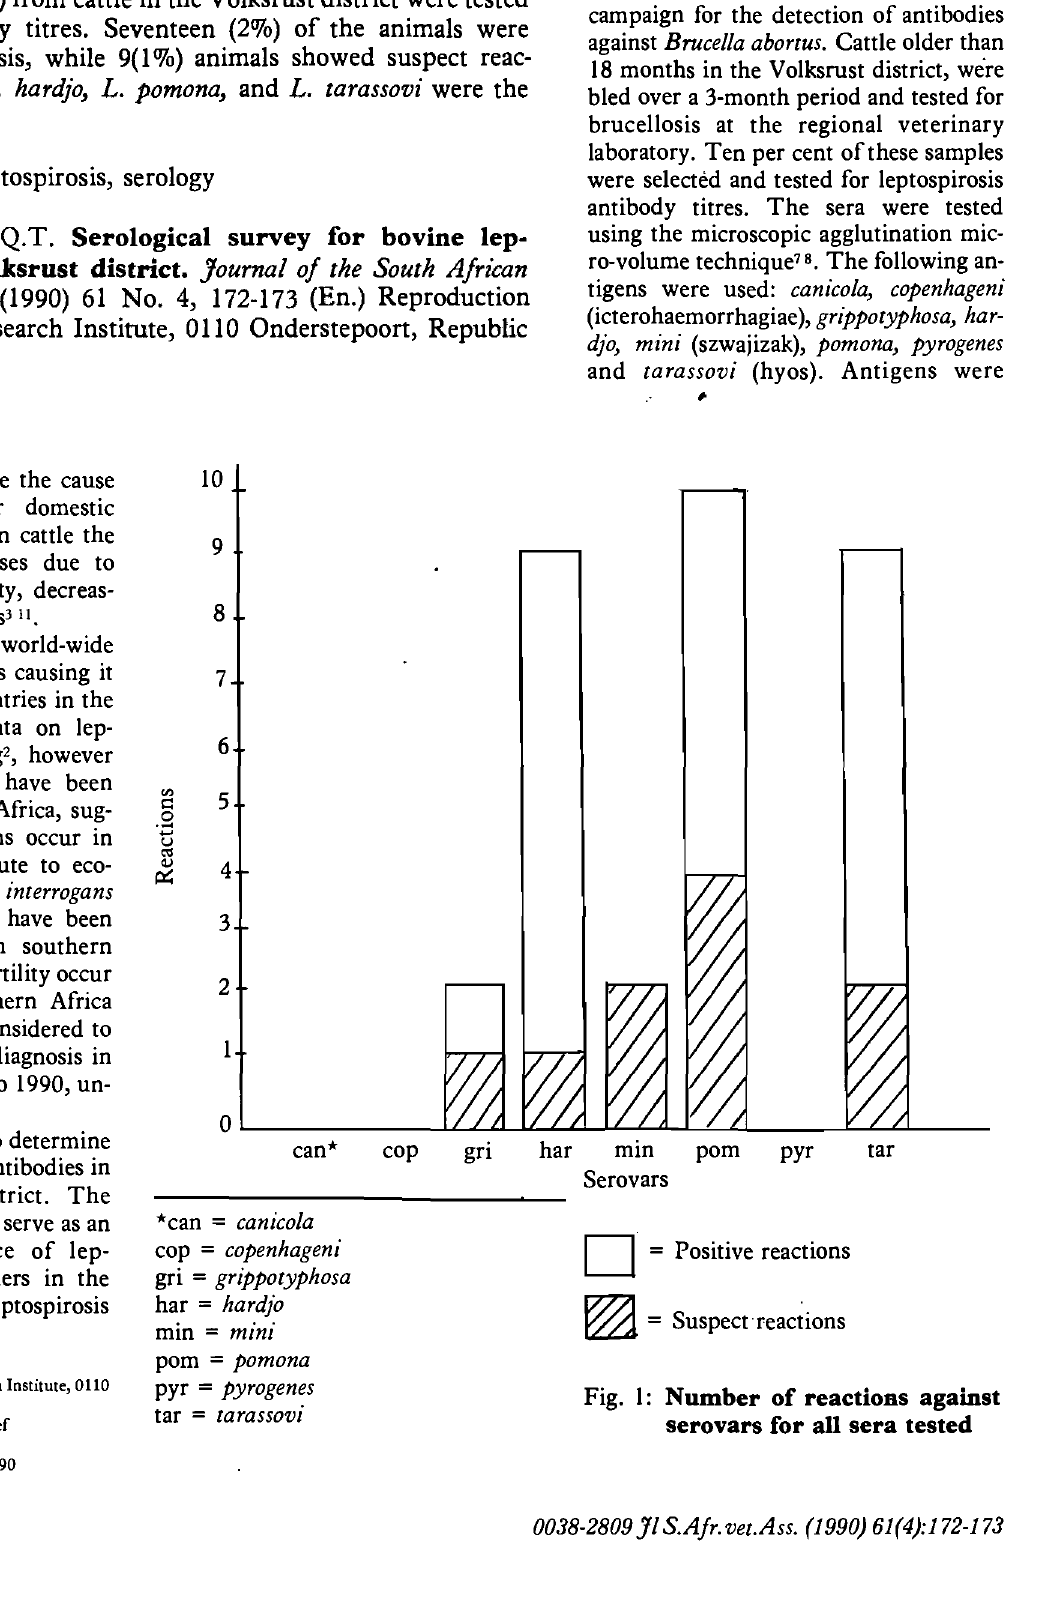
Fig. I: Number of reactioBs against serovars for all sera